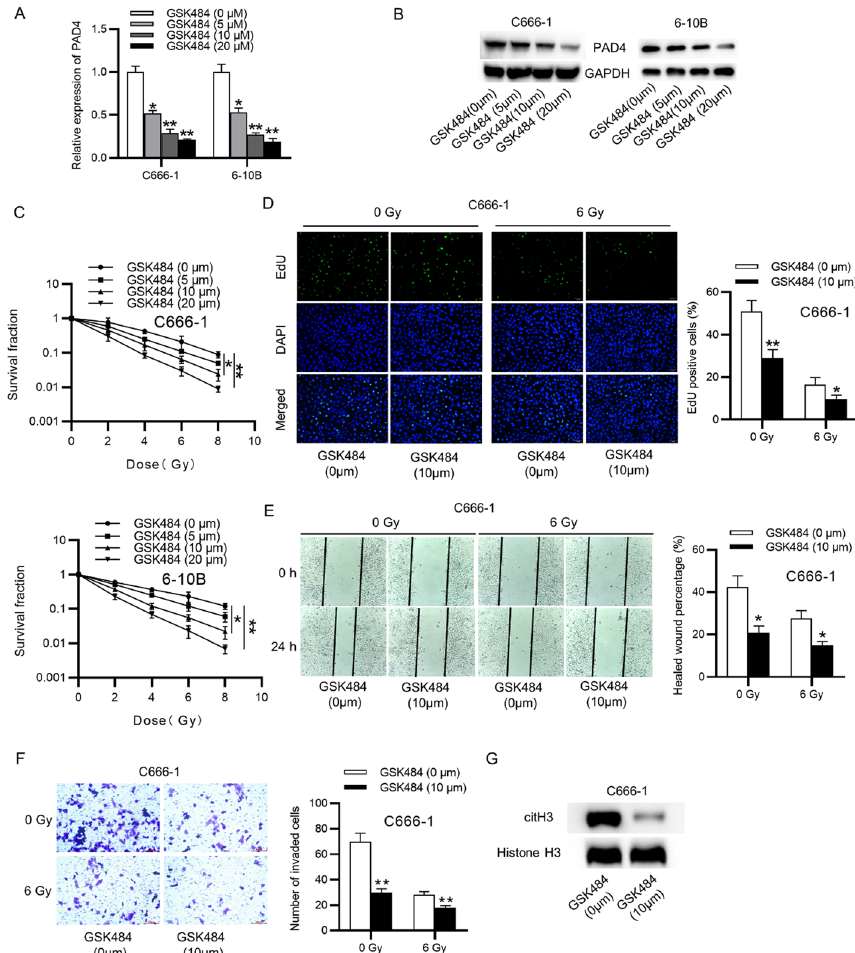
Fig. 3 Inhibition of PAD4 promotes the radiosensitivity and cellular processes in NPC. A , B The PAD4 level after treatment with GSK484 by RT-qPCR and western blot. C Colony formation assay of NPC cells treated with diferent concentrations of GSK484. One-way ANOVA with Tukey’s post hoc test. D Cell proliferation in NPC cells treated with GSK484 or not by EdU assay, at 24 h after 6 Gy irradiation. E , F Migration and invasion in NPC cells treated with GSK484 or not by wound healing and Transwell assays, at 24 h after 6 Gy irradiation. G The level of citH3 protein in NPC cell treated with GSK484 or not was measured by western lot. Unpaired Student’s test. *p < 0.05, **p <